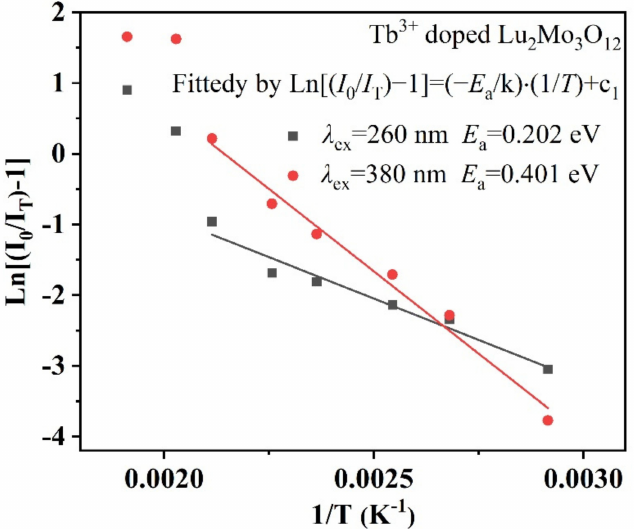
Figure 12. Plots of ln[( I 0 / I T )1] corresponding to 1/T in Tb 3+ -doped Lu 2 Mo 3 O 12 phosphor prepared at 1000 ◦